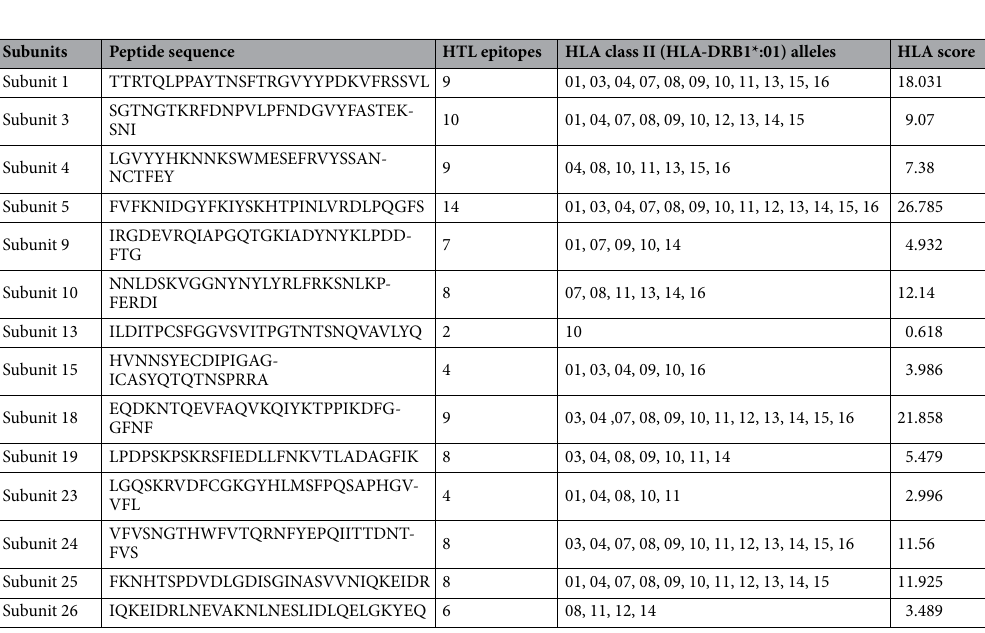
Table 7. HTL epitopes prediction